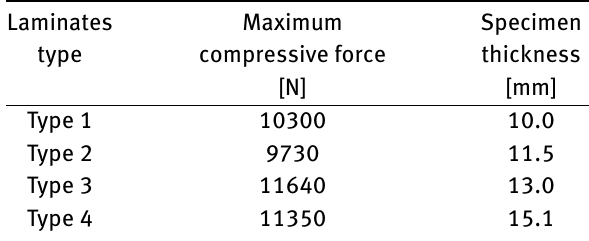
Figure 14: Bending test model for material model validation